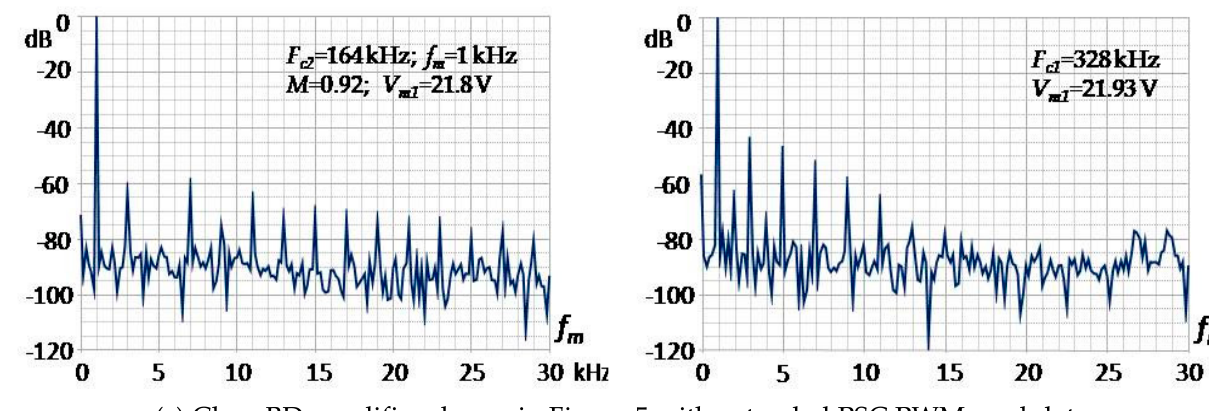
Figure 8. Simulated THD + N frequency responses of three tested amplifiers in the band up to 30 kHz.